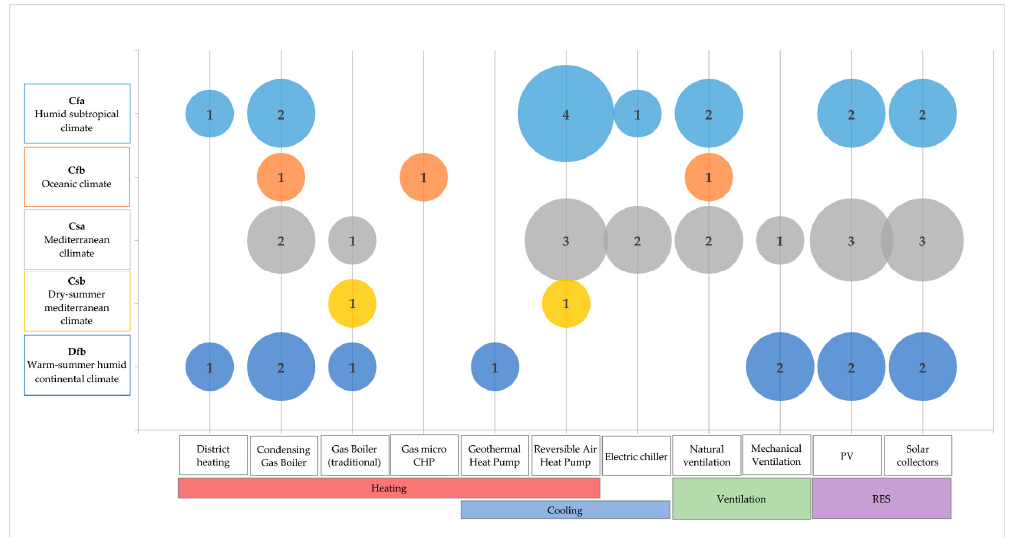
Figure 21. Optimal EEMs for energy systems—multi-family residential buildings.